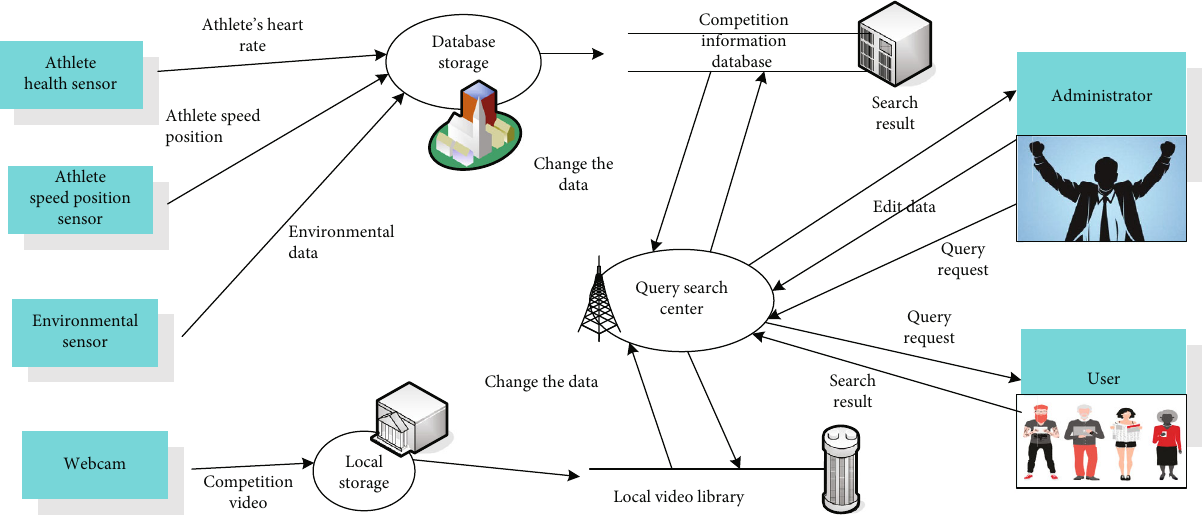
Figure 2: Data fl ow diagram-0 layer